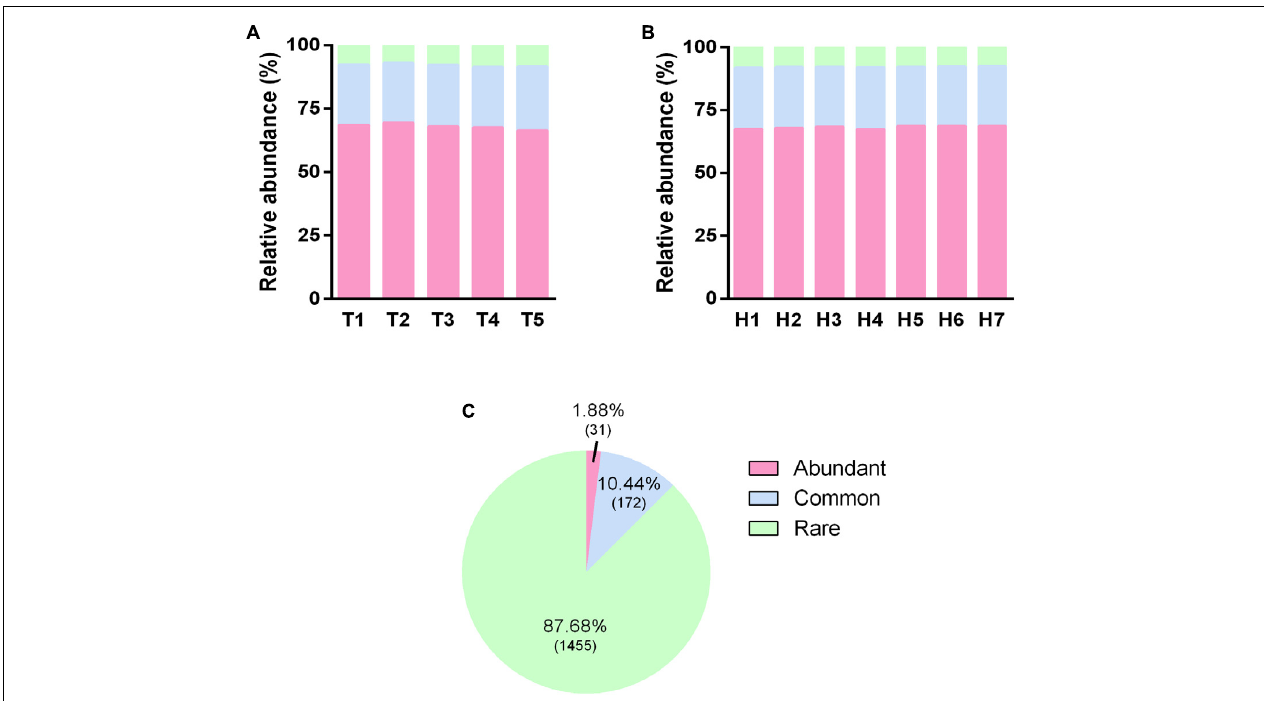
FIGURE 5 | Distribution of OTUs with different occurrence frequency. (A) Relative abundance of OTUs with different occurrence frequency in five sampling time points. (B) Relative abundance of OTUs with different occurrence frequency in seven sampling heights. (C) The percentage of OTUs number with different occurrence frequency, the according numbers of OTUs were presented in the